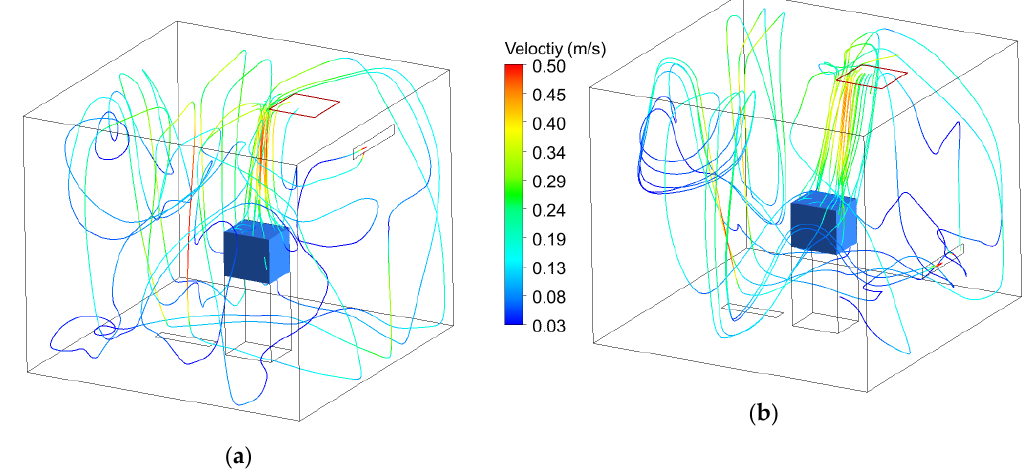
= 2.3 m setting; and, ( b ) H = 0.8 m 2 source: ( a ) H